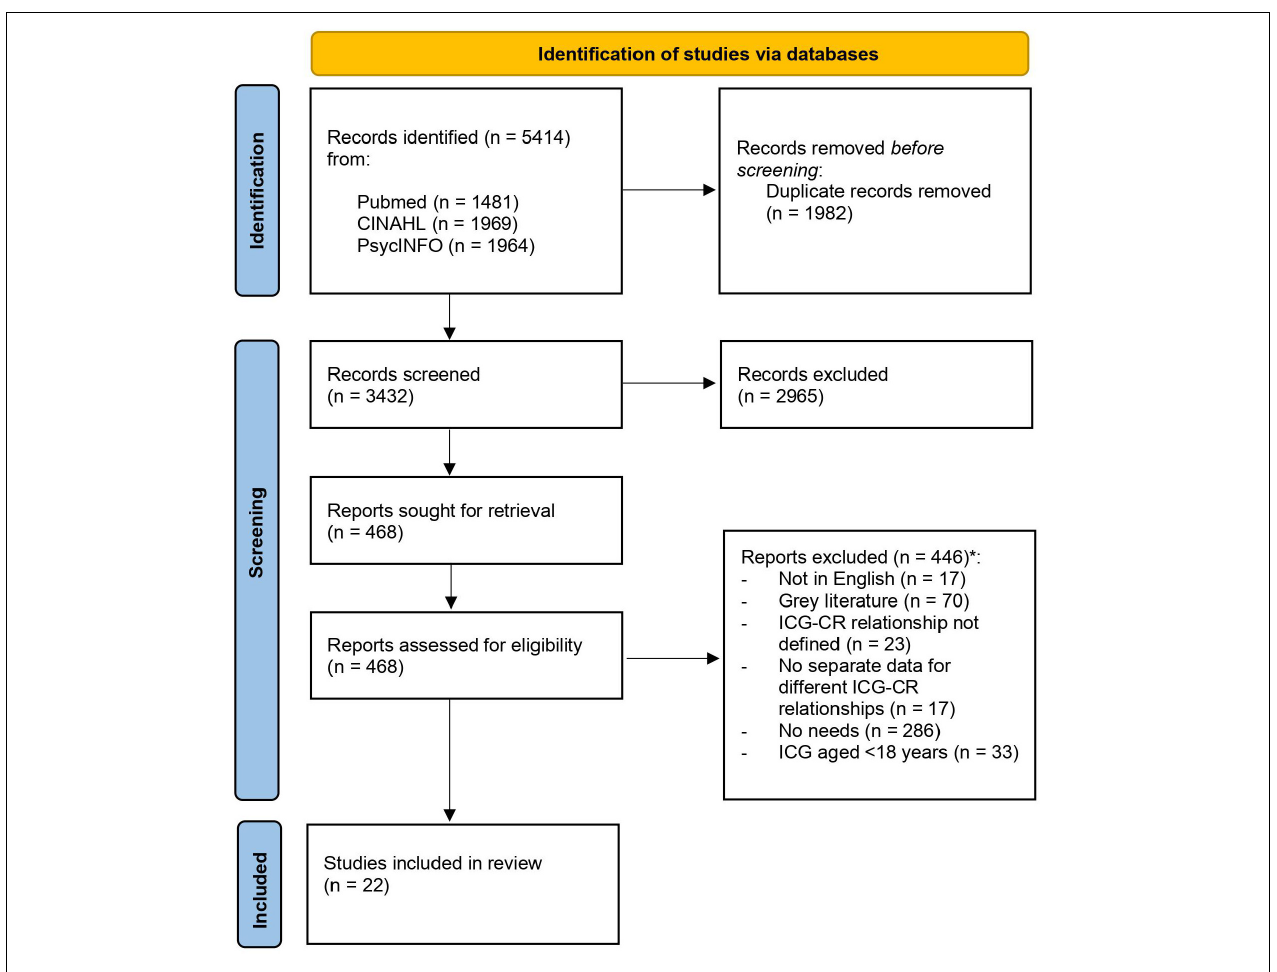
FIGURE 1 | Preferred Reporting Items for Systematic Reviews and Meta-analyses (PRISMA) flow diagram of study selection process. *The reports were matched with the inclusion and exclusion criteria in the order presented here. In case a report did not meet a specific exclusion or inclusion criteria it was immediately excluded and not matched for the other criteria. For example, if the article was not published in the English language, it was excluded without checking for other